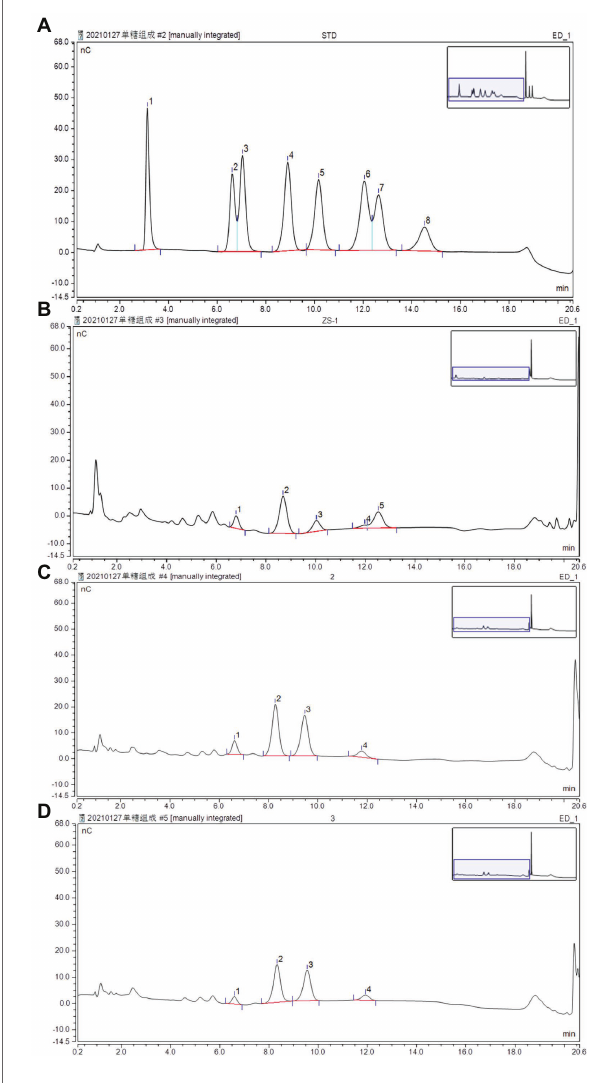
FIGURE 4 | Determination of monosaccharides by HPLC using the pulsed amperometric detector (PAD) detector: (A) standard chromatogram of monosaccharide mix contains fucose (1), arabinose (2), rhamnose (3), galactose (4), glucose (5), xylose(6), mannose (7), and fructose (8); (B) determination of monosaccharides in APP40; (C) determination of monosaccharides in APP60; and (D) Determination of monosaccharides in APP80.